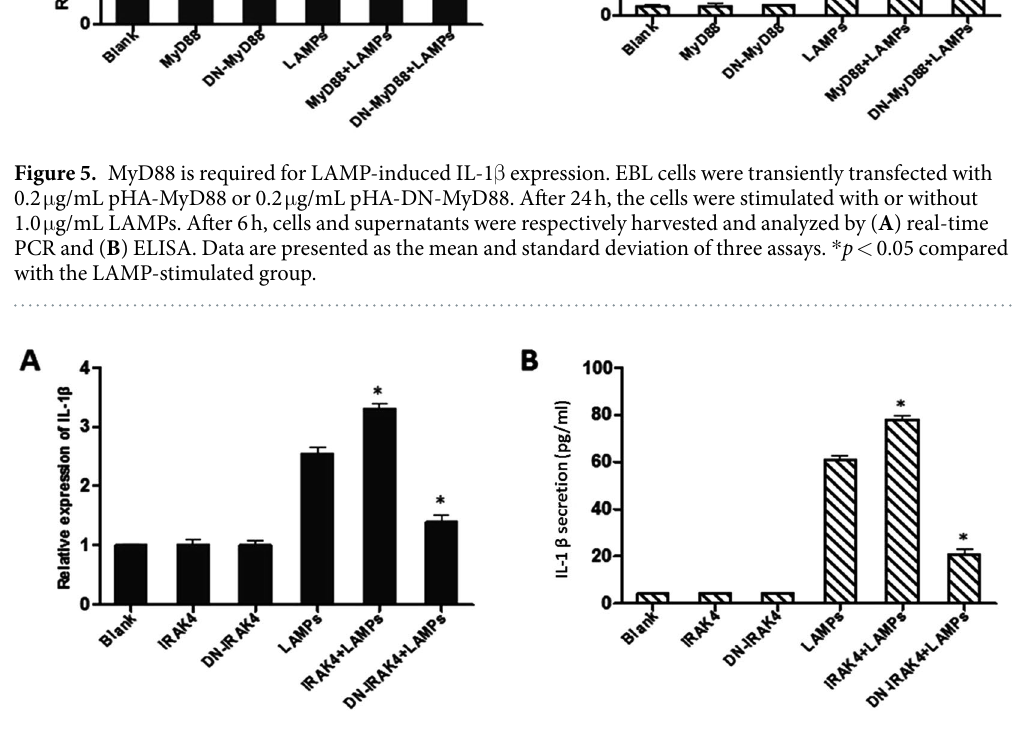
Figure 6. IRAK4 is required for LAMP-induced IL-1 β expression. EBL cells were transiently transfected with 0.2 μ g/mL pHA-IRAK4 or 0.2 μ g/mL pHA-DN-IRAK4. After 24 h, the cells were stimulated with or without 1.0 μ g/mL LAMPs. After 6 h, cells and supernatants were respectively harvested and analyzed by ( A ) real-time PCR and ( B ) ELISA. Data are presented as the mean and standard deviation of three assays. * p < 0.05 compared with the LAMP-stimulated